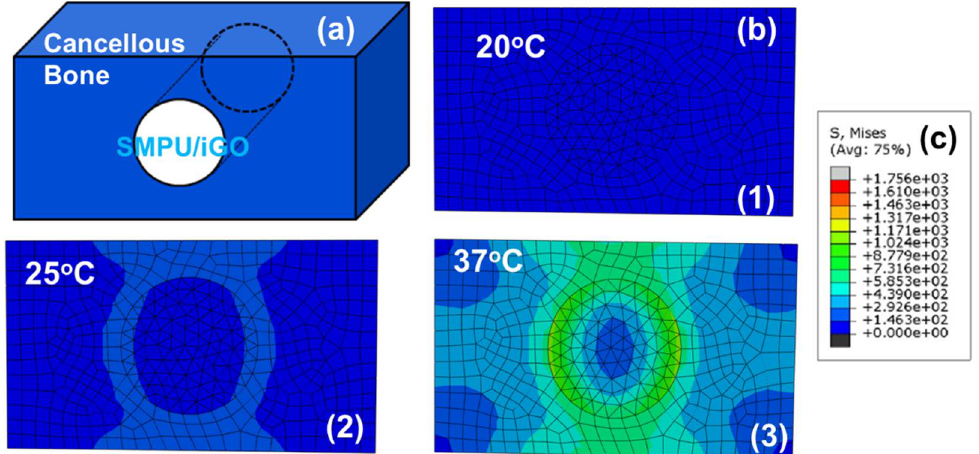
Figure 5. Finite element analysis (FEA) simulation of the SMPU / iGO: ( a ) the simplified material-bone model; ( b ) the equivalent stress distribution by FEA during the recovery process at 20, 25 and 37 °C; and ( c ) the scale of the stress distribution.